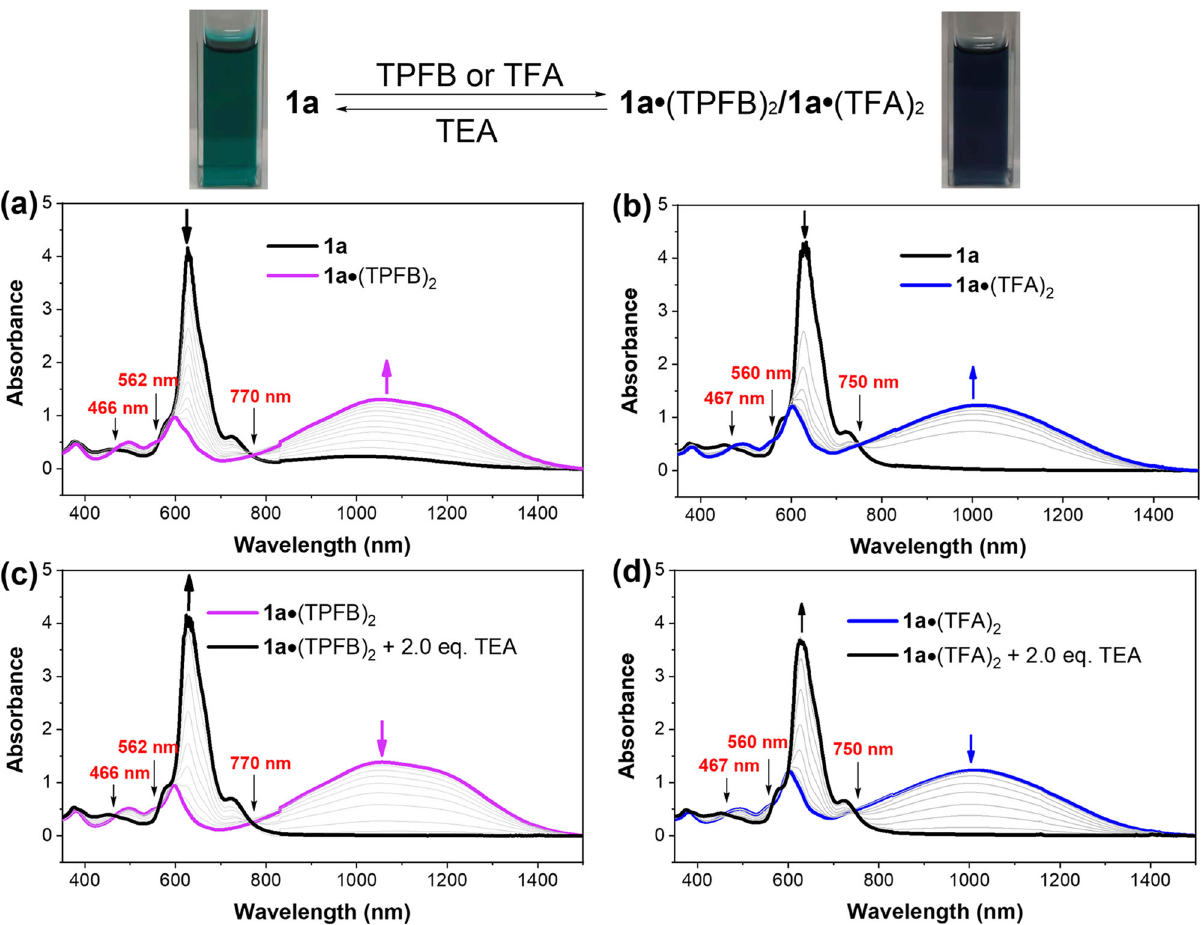
Fig. 6 UV – vis – NIR absorption changes of 1a in the reversible Lewis acid-base reaction. a Schematic illustration of the reversible Lewis acid-base reaction between 1a and corresponding acids. b Absorption spectral changes during the titration of 1a with TPFB (left) and TFA (right). c Absorption spectral changes during the titration of 1a (cid:129) (TPFB) 2 (left) and 1a (cid:129) (TFA) 2 (right) with